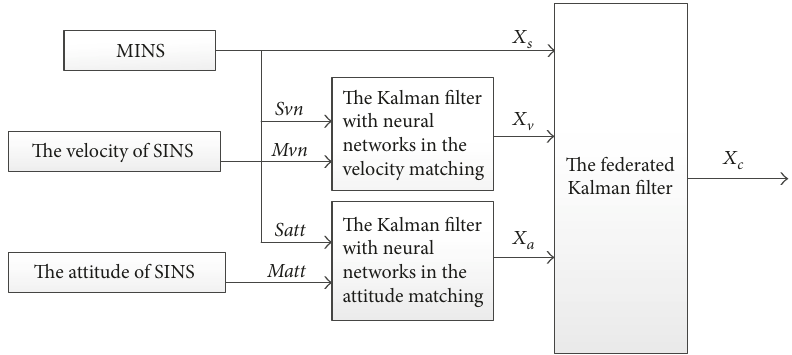
Figure 4: The principle diagram of the federated Kalman filter with neural